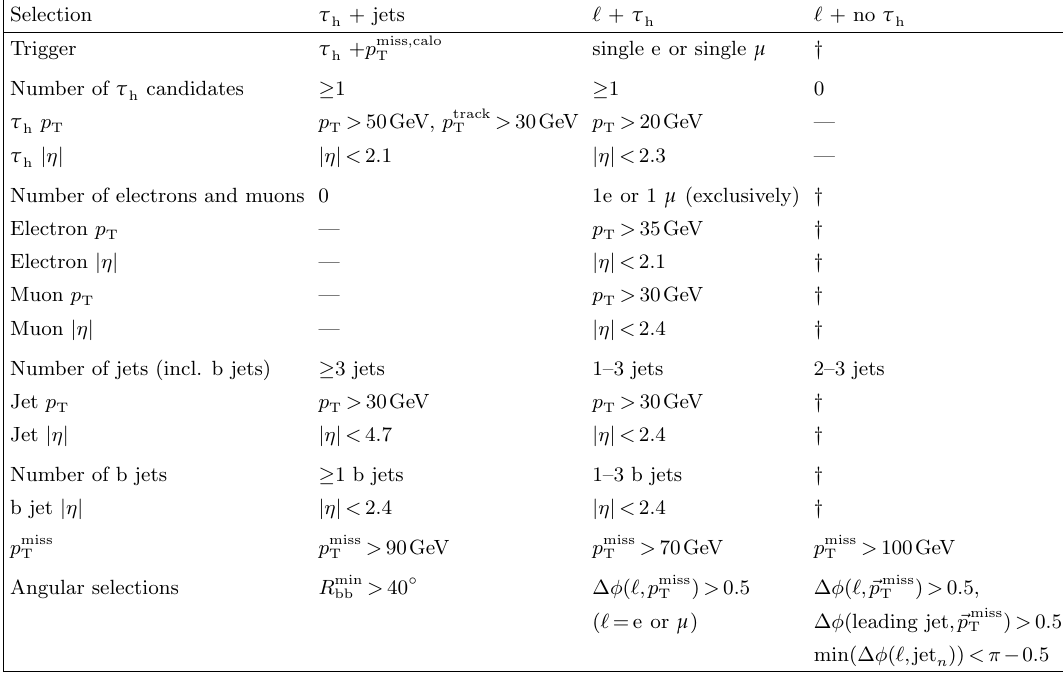
and ‘ + no t h h refers to n